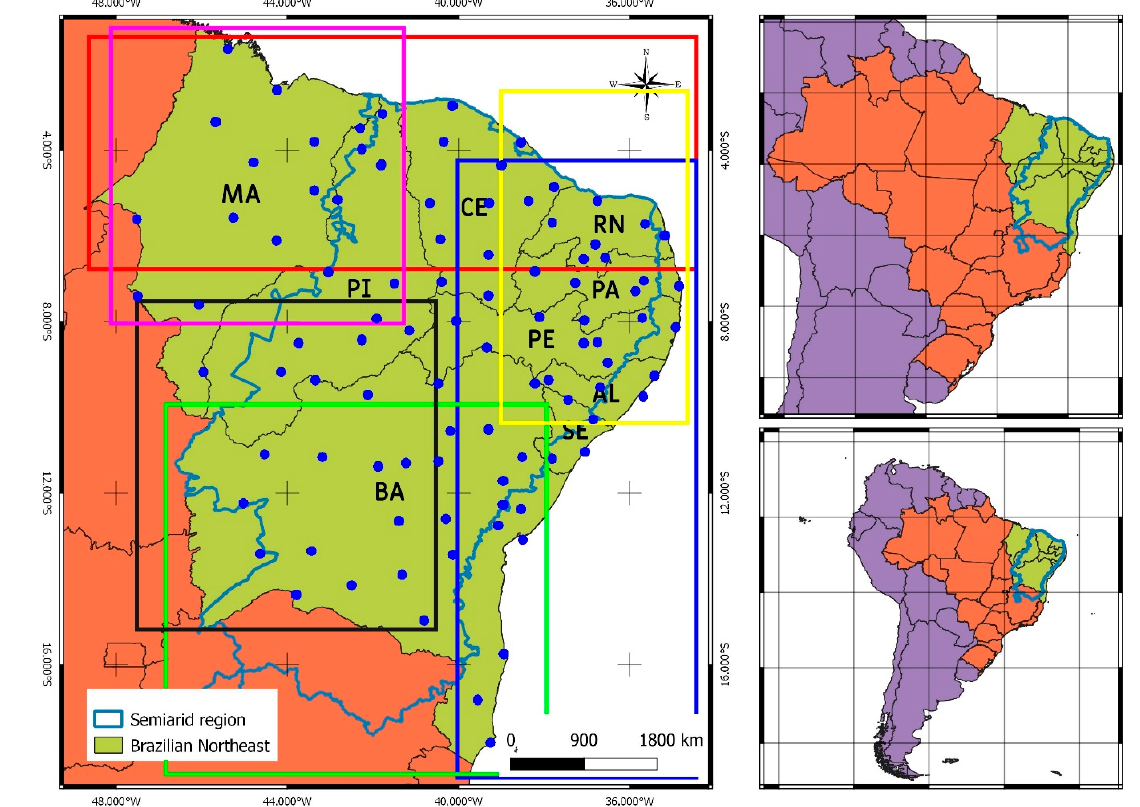
Figure 1. Map of the Brazilian Northeast with the delimitation of the semiarid region and its location in relation to Brazil and South America, respectively. Regarding the left panel, points representing INMET’s weather stations are highlighted in blue. Concerning subregions, we highlight the north of NRB in red, the northwest in violet, the northeast in yellow, the east in blue, the south in green and the southwest in black.